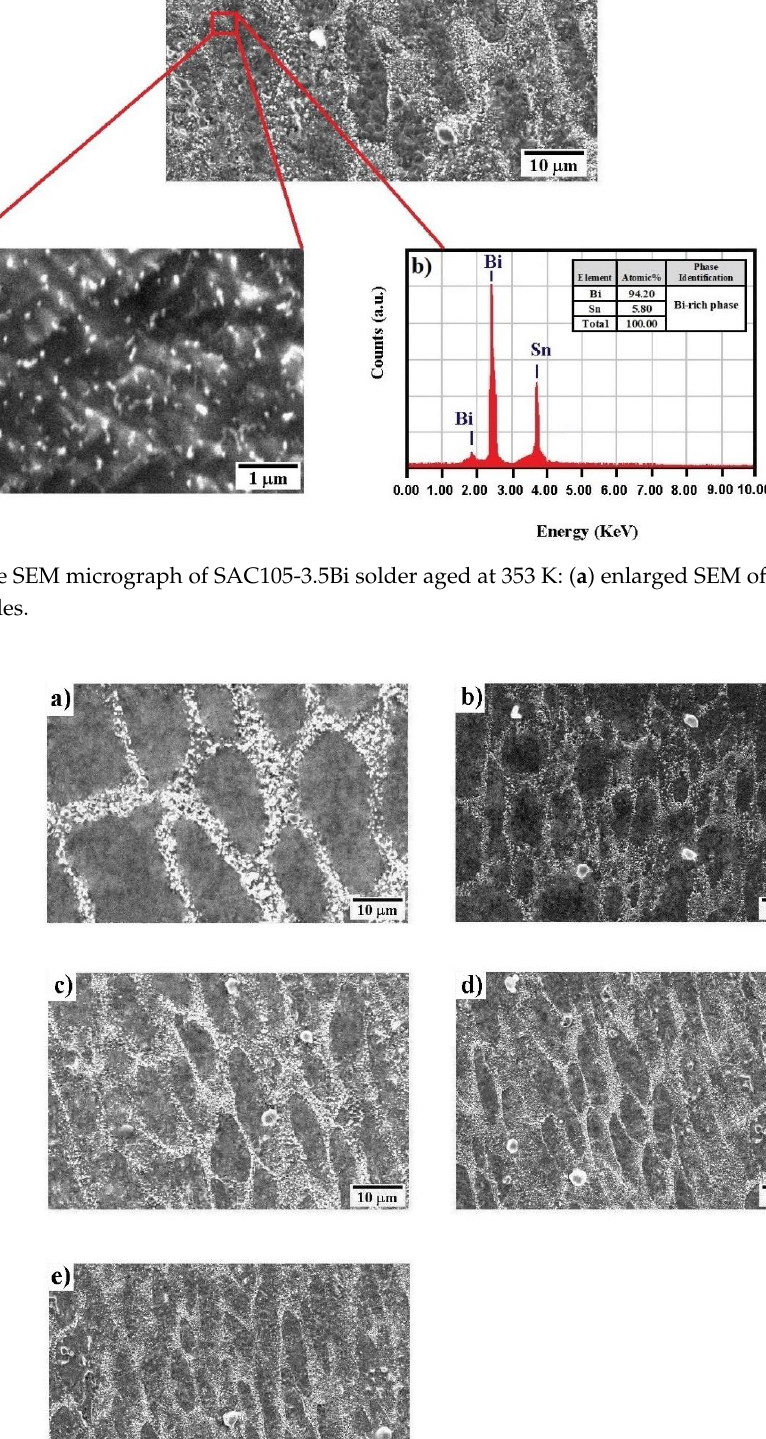
Figure 10. Dependence of steady state creep rate, έ st , on testing temperatures, T t , for different Bi contents. Aging temperatures, T a , applied are ( a ) 353, ( b ) 373, ( c ) 393, and ( d ) 413 K.